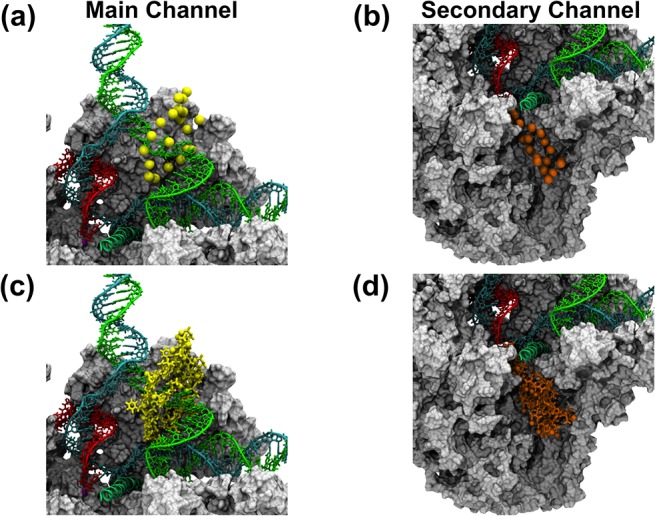
MD relaxation of NTP in the main channel and the secondary channel.(a-b) Initially, the points constituting the entry routes through the main and secondary channels were divided into 20 clusters. The yellow and orange spheres represent the center of each cluster for the main channel and the secondary channel, respectively. (c-d) A NTP molecule (in licorice presentation) accompanied by a bound magnesium atom (sphere representation) was aligned to each of the cluster centers (shown in (a-b)) by its center of mass (see Methods). These conformations were used as starting points for relaxation via MD simulations (see Methods). The template DNA, non-template DNA and mRNA strands are shown in cyan, green and red, respectively, with tube and licorice representations. The cut-view of the protein is shown in grey with a surface representation.